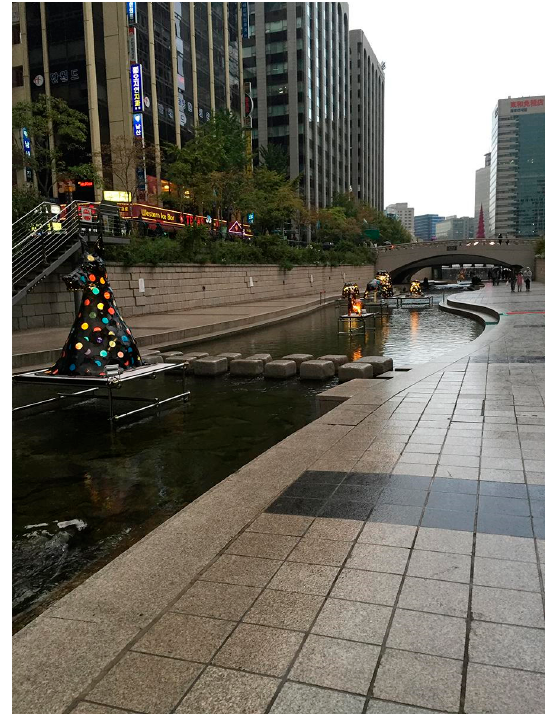
Figure 5. First section with Cheonggye plaza in the distance.